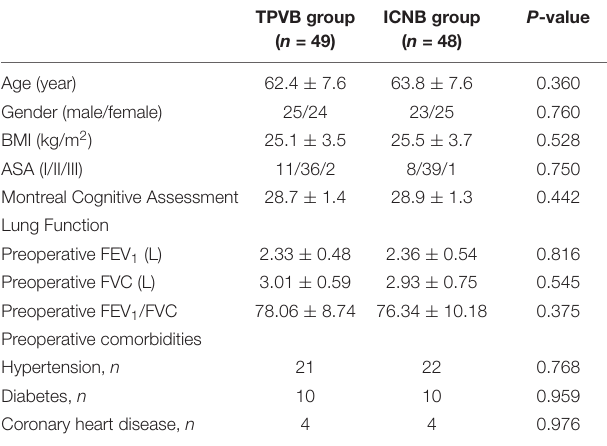
TABLE 3 | Comparison of secondary outcomes between the two